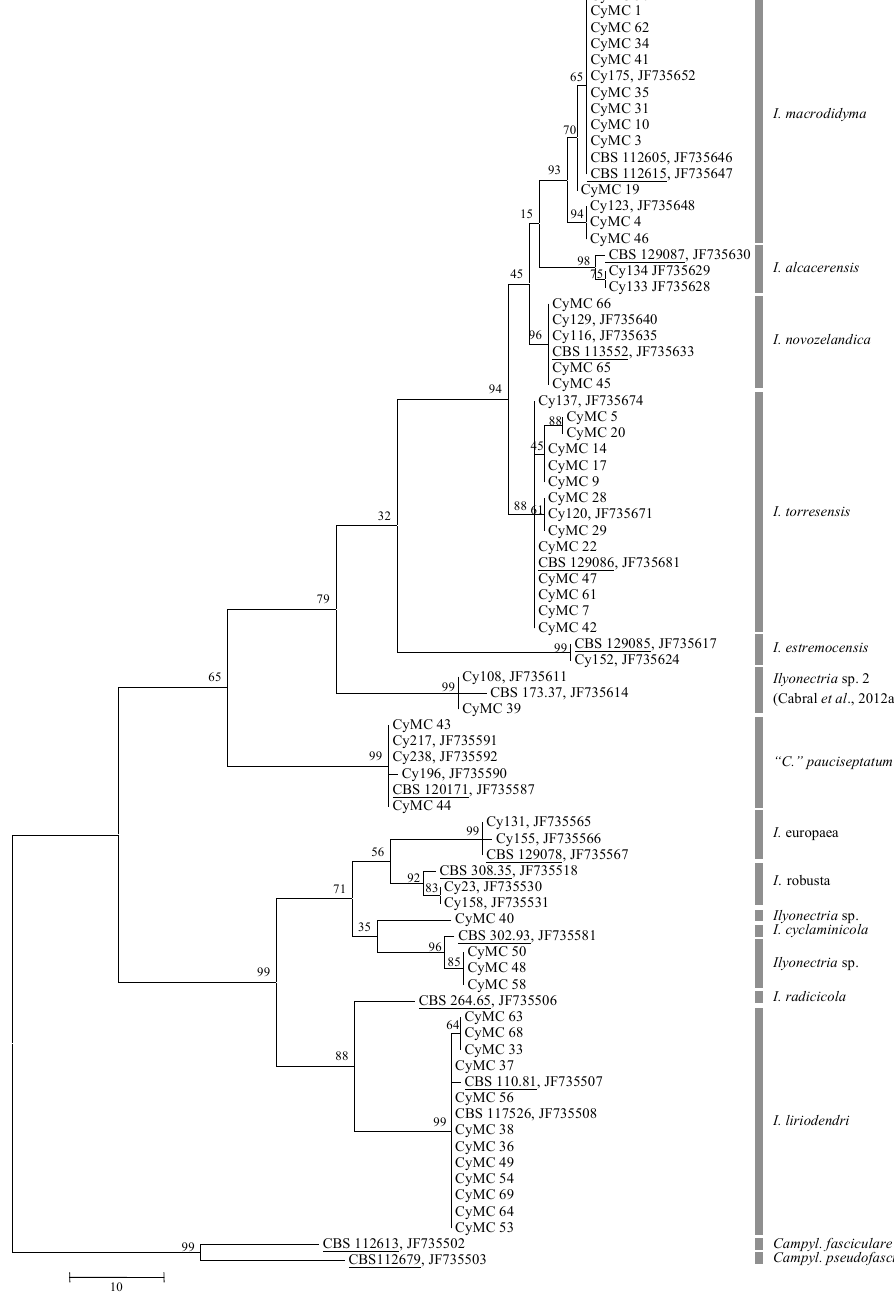
Figure 3. The first of 276 equally most parsimonious trees obtained from part of Histone H3 sequence alignment of Ilyonec- tria isolates and relatives with a heuristic search using MEGA version5. The tree was rooted using Campylocarpon isolates as outgroup sequences and bootstrap support values are indicated near the nodes. Ex-type strains are underlined. Isolates obtained in this study start with CyMC, sequences download from GenBank have the accession number after the isolate number. Scale bar shows 10